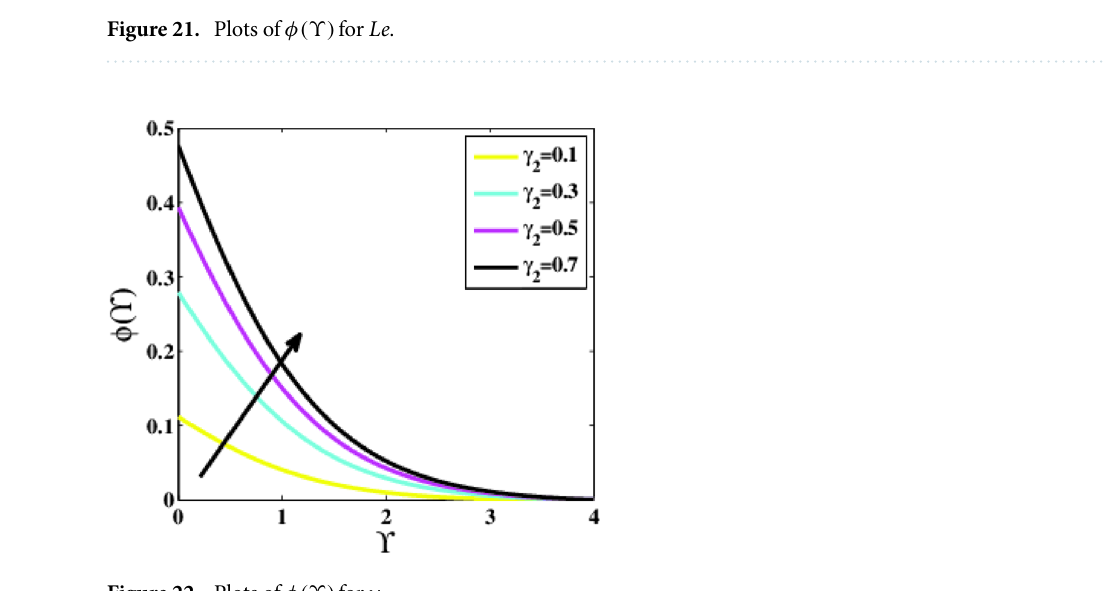
Figure 22. Plots of φ(ϒ) for γ 2 .